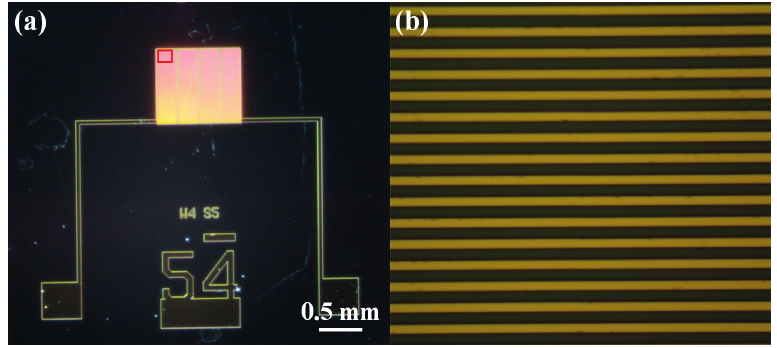
Figure 2. ( a ) Optical microscope image of the fabricated IDE device; ( b ) enlarged image of enclosed area in ( a